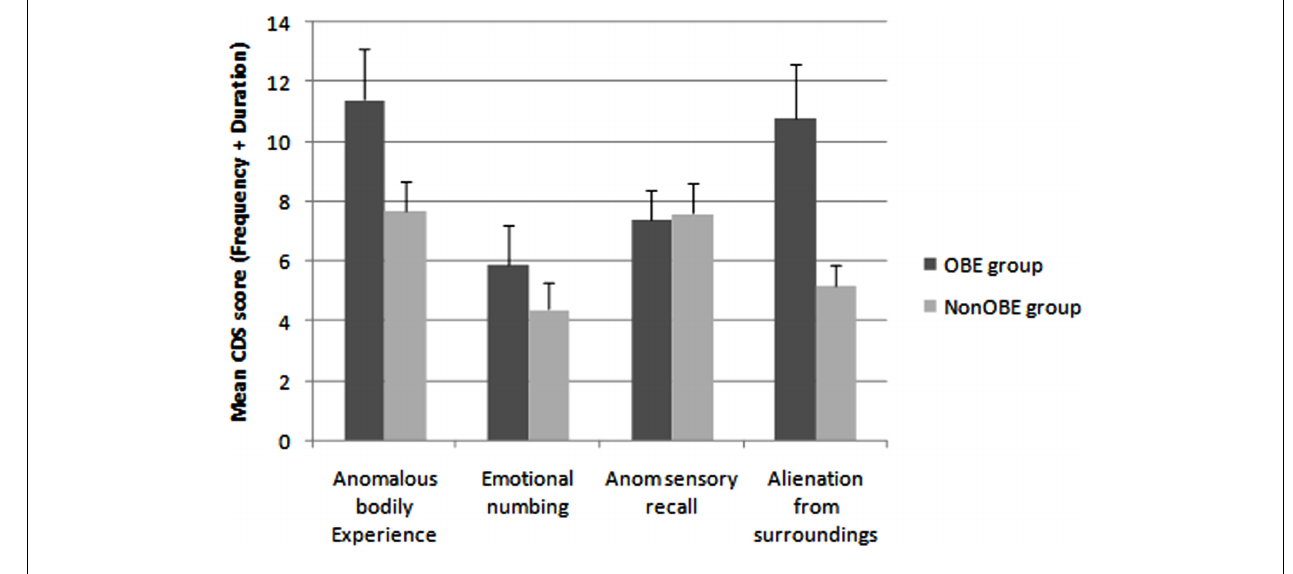
FIGURE 3 | Mean CDS scores for each of the 4 subscales (identified by Sierra and Berrios, 2000) plotted for both the OBE and non-OBE control groups (error bars = 1 SE) .